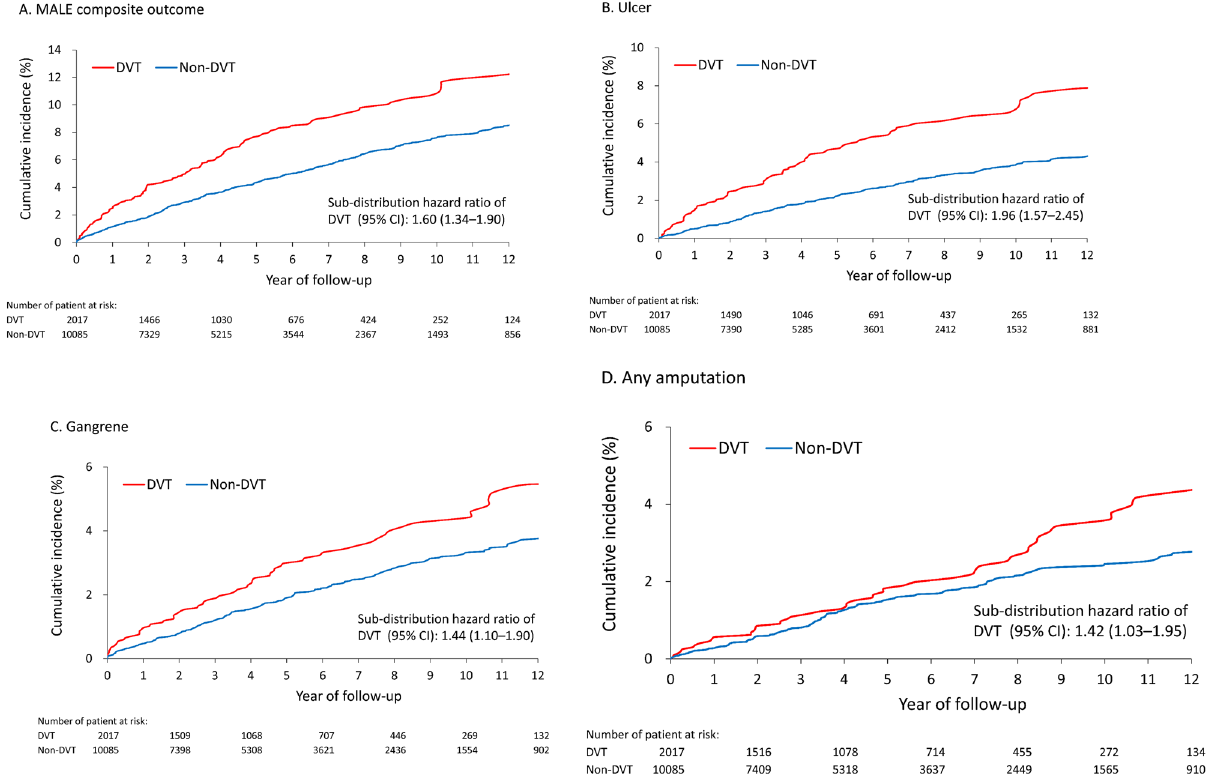
Figure 1. Cumulative incidence function of MALE composite outcome ( A ), foot ulcer ( B ), gangrene ( C ) and any amputation ( D ) of the patients with type 2 diabetes stratified by a history of deep vein thrombosis hospitalization during follow-up in the propensity score-matched